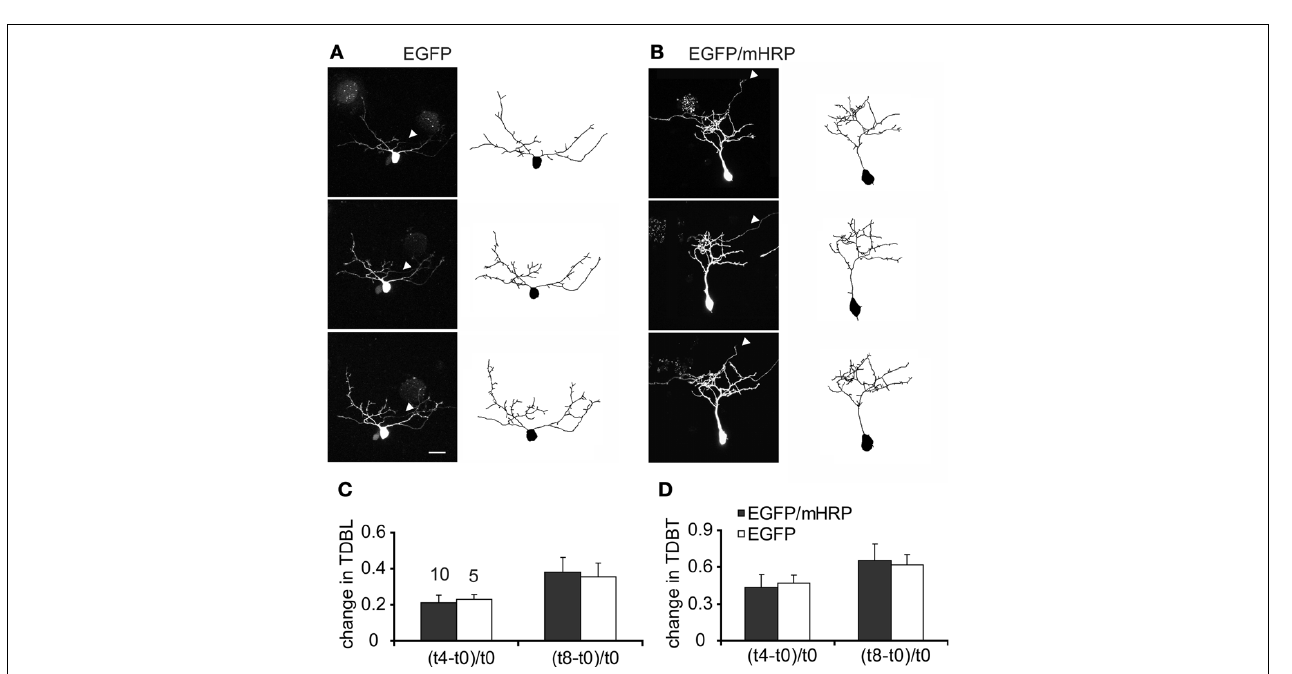
magnifi cation of insets (B–D) in ( A) demonstrated that stable (B) and extended (C) dendritic branches and axonal boutons (D) can be detected equally well by both EGFP and mHRP expression. Scale bar: 20 µm in ( A) , 5 µm in (B) , which applies to (C ) and (D) .